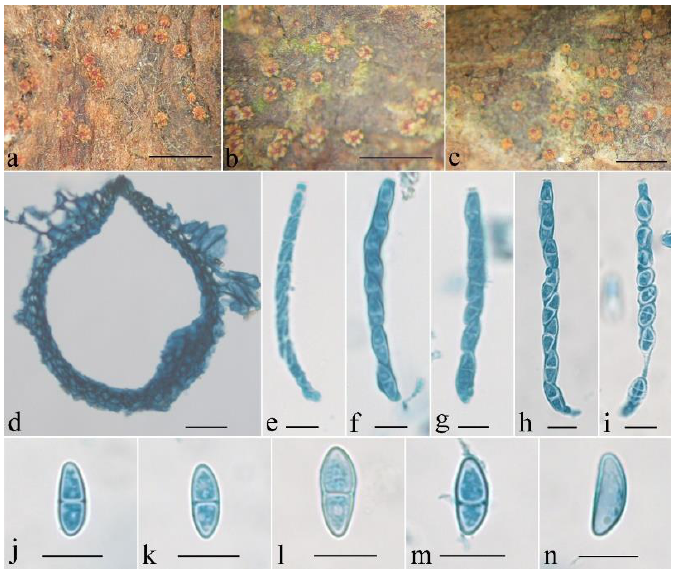
Figure 4. Macroscopic and microscopic morphology of Penicillifer sinicus (HMAS 247865). ( a – c ) Ascomata on natural substratum; ( d ) median section of perithecium in lactophenol cotton blue; ( e – i ) asci with ascospores in lactophenol cotton blue; ( j–n ) ascospore in lactophenol cotton blue. Bars: ( a – c ) = 1 mm; ( d ) = 50 µ m; ( e – n ) = 10 µ